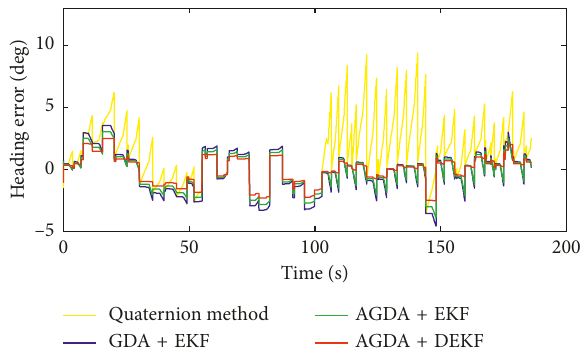
Figure 9: Heading angle error results.